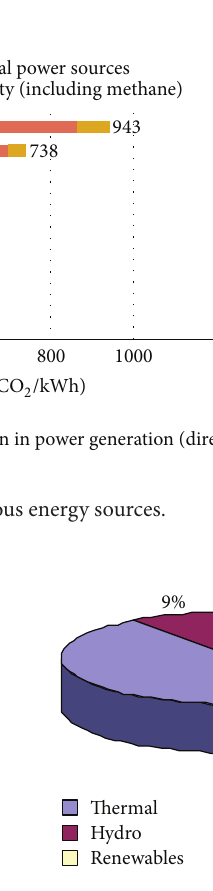
Figure 7: Electricity generation mix in Egypt (2011). Table 4: Fuel consumption for generating electricity in